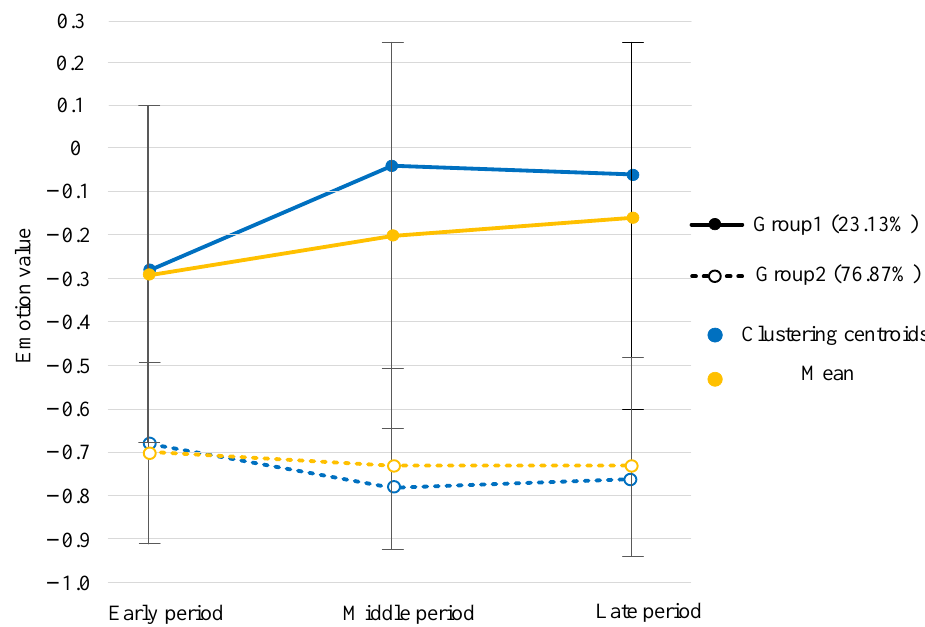
Figure 2. Longitudinal emotional changes for sample users in the ODC.